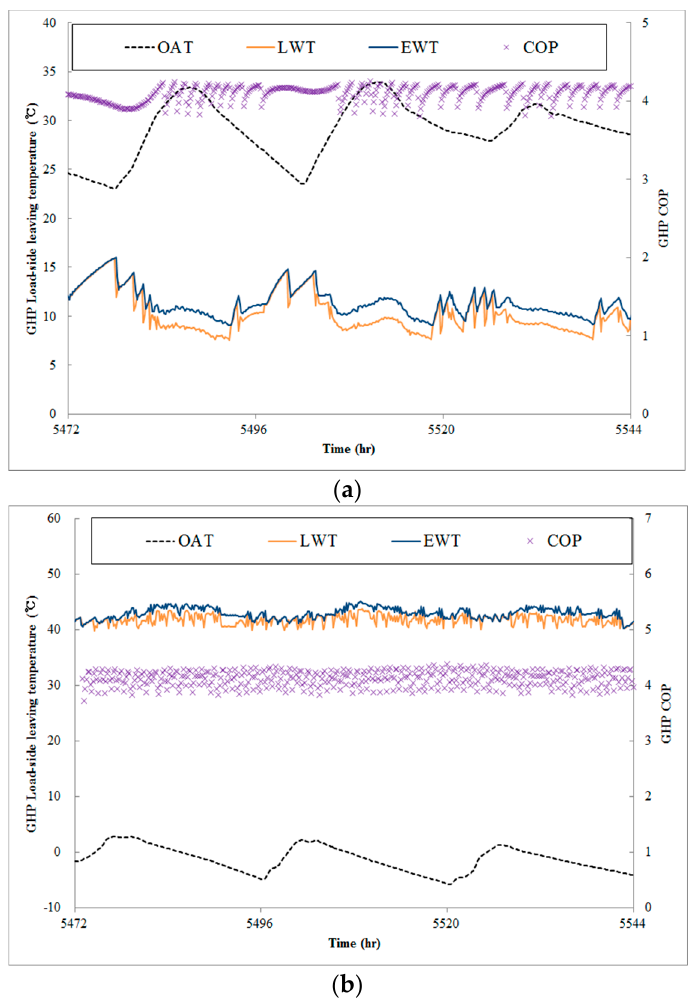
Figure 10. Entering and leaving temperatures and COPs of GHP system by COP sequential control: ( a ) Summer; ( b ) Winter.